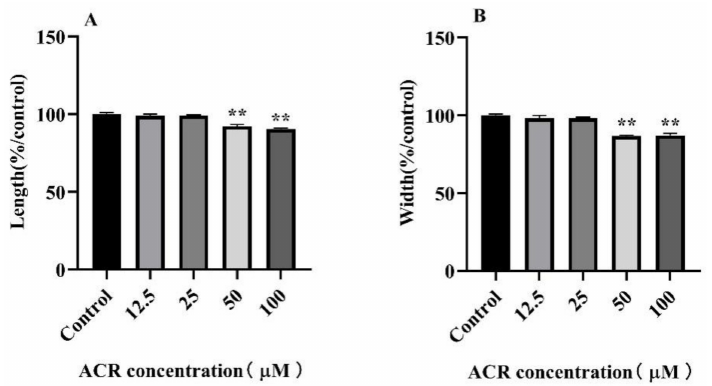
Figure 2. Effect of ACR exposure (12.5, 25, 50, and 100 µ M for 48 h) on length ( A ) and width ( B ) of C. elegans . Values are means ± SD. ** Compared with the control group p < 0.01.